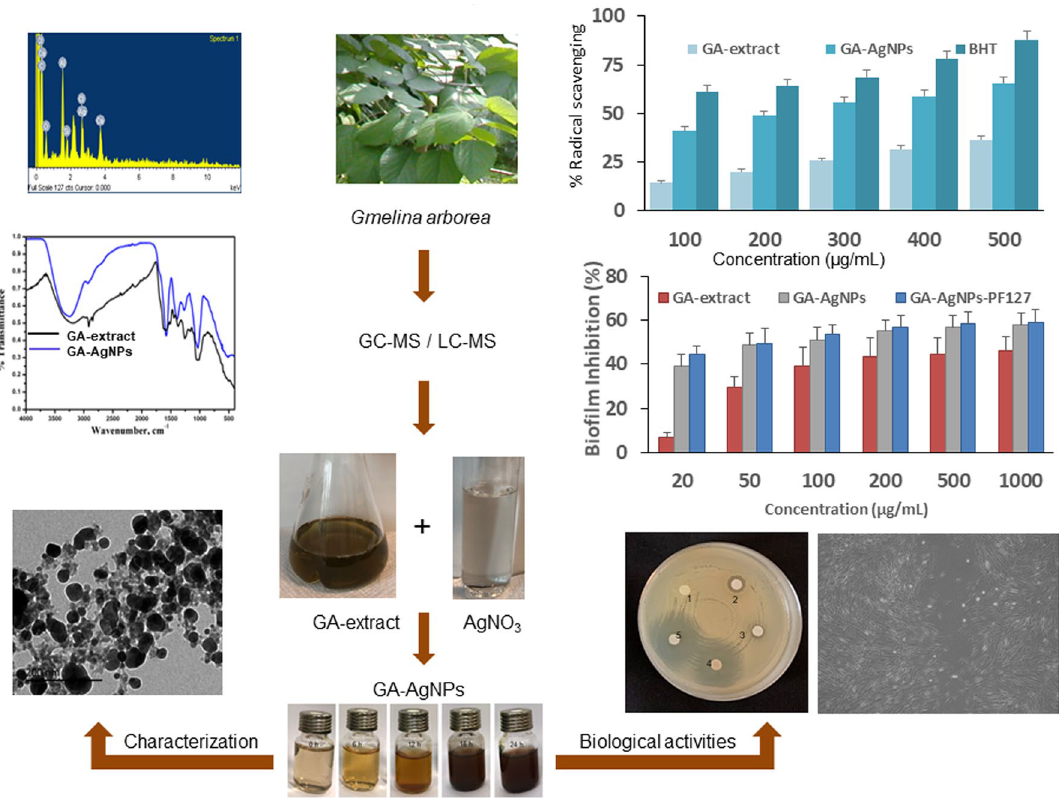
Figure 1. Phyto-fabrication of GA-AgNPs from leaf extract of Gmelina arborea and their characterization and biological